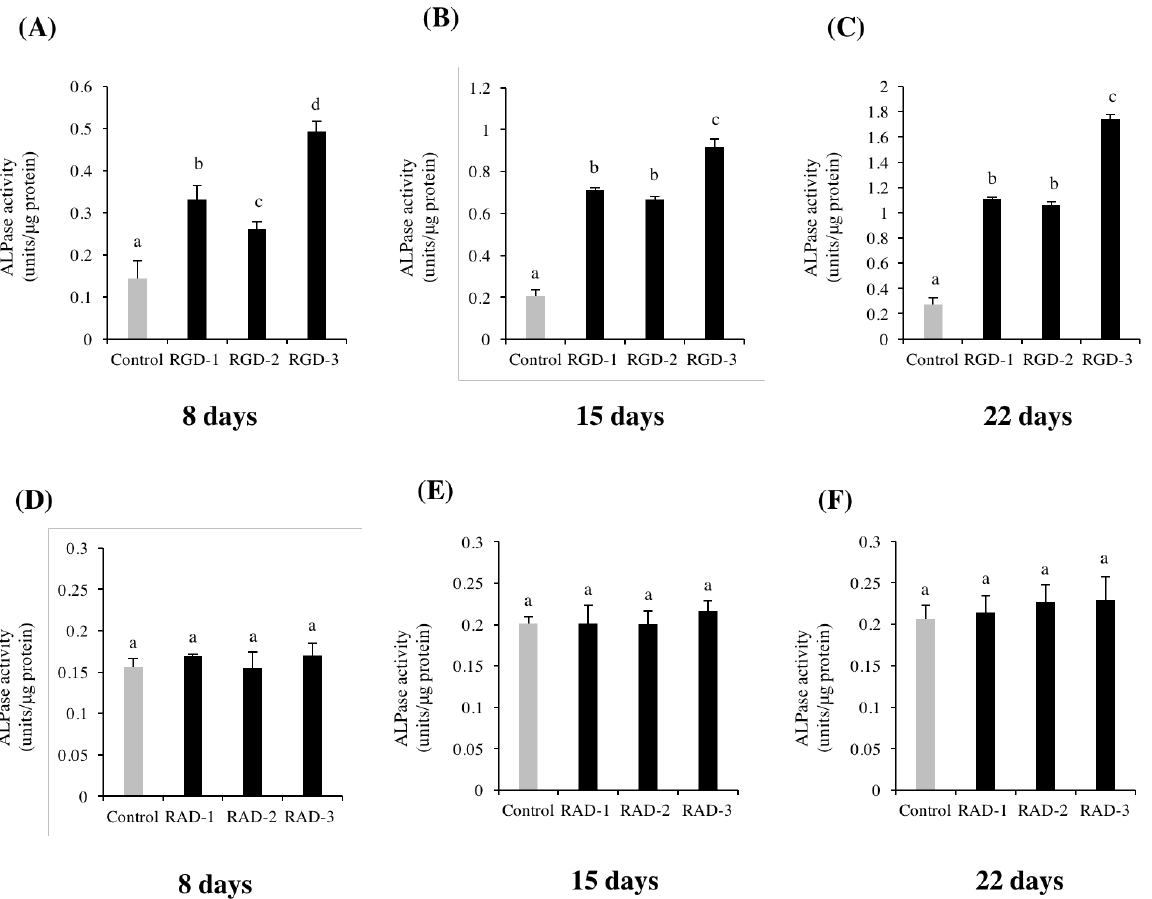
Figure 3. Effects of DPP-derived RGD peptides and RAD peptides on the ALP activity of hDPSCs. hDPSCs were spread onto non-TCPP plates coated with 1 M RGD peptides (RGD-1, RGD-2 and RGD-3) or dH 2 O (control). ALP activity was assessed on days 8 ( A ), 15 ( B ) and 22 ( C ). Cells were spread on to 1 M RAD peptide-coated plates (RAD-1, RAD-2 and RAD-3) and ALP activity was assessed on days 8 ( D ), 15 ( E ) and 22 ( F ). The relative ALP activity in all three RGD peptides were higher than in the control group. RAD peptides showed comparable results to the control group. n = 3, different lowercase characters denote significant differences compared to the control ( p < 0.05).